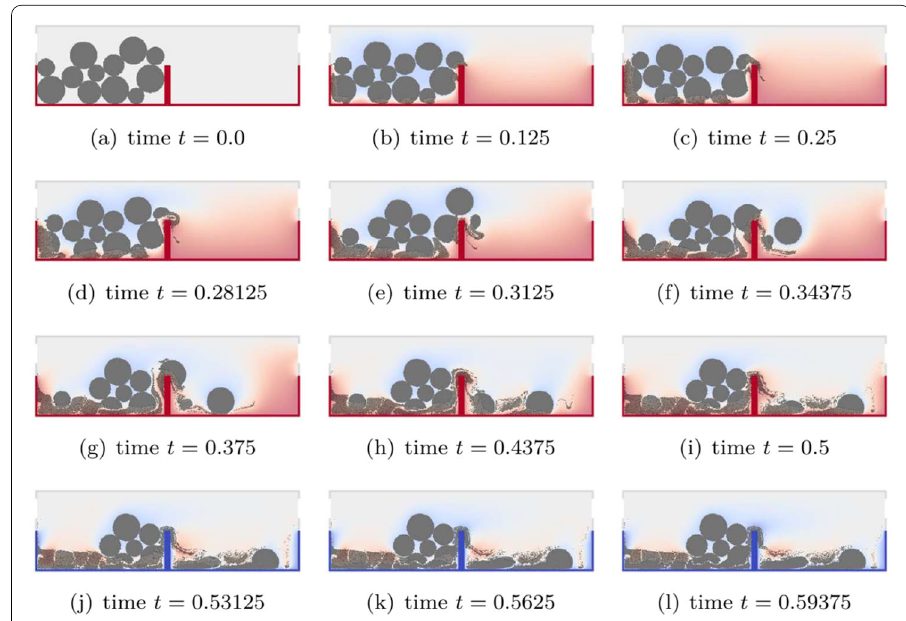
Fig. 12 Powder grains exposed to a highly dynamic gas flow: time series of the obtained results with temperature field ranging from 0 . 0 (blue) to 100 . 0 (red)